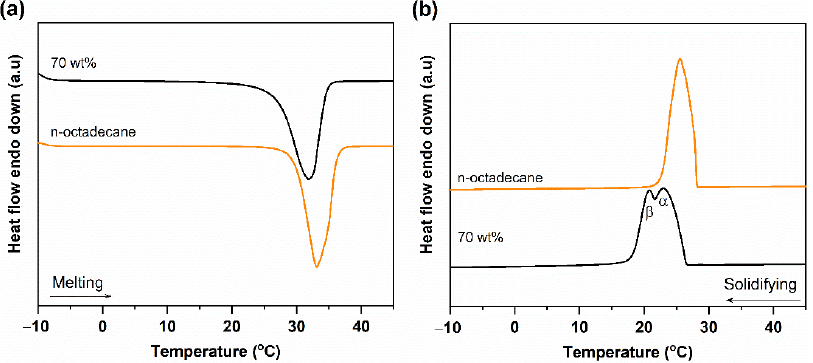
Figure 5. ( a ) Melting and ( b ) solidification differential scanning calorimeter (DSC) curves of pure n-octadecane and the 70 wt% PCC. Table 1. Phase change properties of n-octadecane and the 70 wt% PCCs.